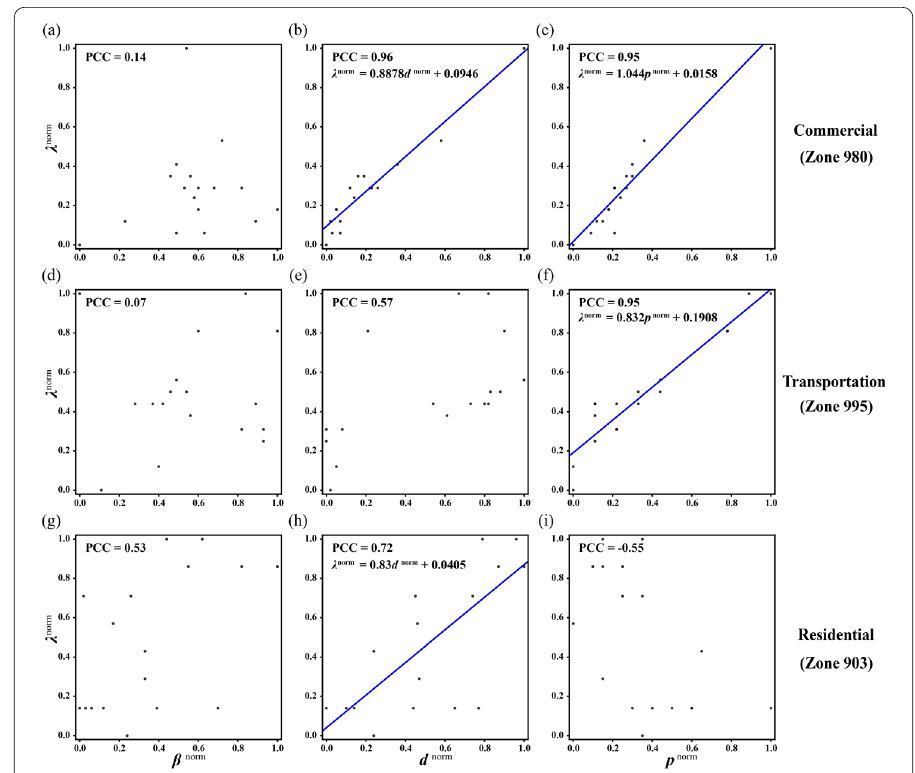
Figure 3 Pearson Correlation Coefficient (PCC) between coupling strength and three indexes. PCC between coupling strength and speed ratio (left column), PCC between coupling strength and average trip distance (middle column), and PCC between coupling strength and fraction of travelers from ordinary zones (right column) for SDNs with destinations at ( a )–( c ) a commercial zone, ( d )–( f ) a transportation hub zone and ( g )–( i ) a residential zone. Normalized parameters are denoted λ norm , β norm , d norm , and p norm . Blue lines denote the regression